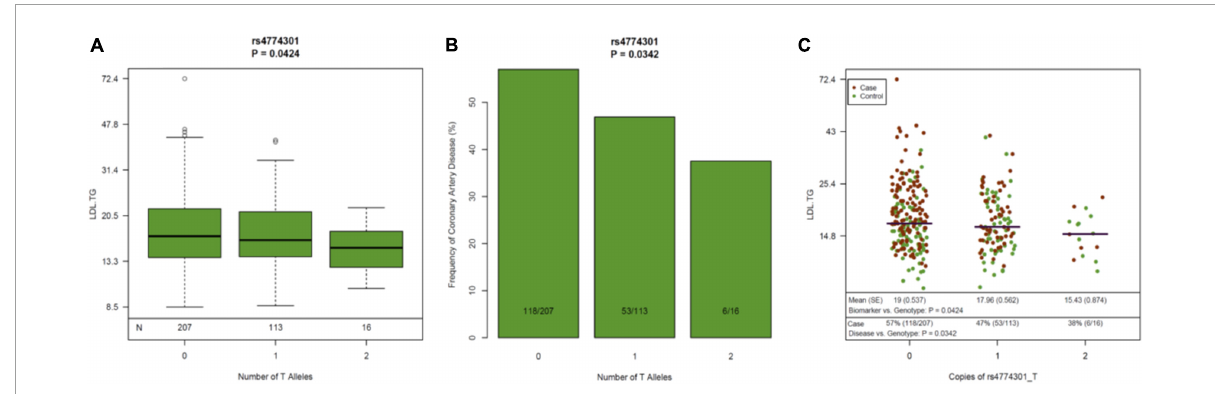
FIGURE4 Genetic variants in the LIPC Gene, Circulating Levels of LDL-TG and Atherosclerosis. The genetic variant rs4774301 in the LIPC genomic region is associated with significantly lower circulating levels of LDL-TG (A) and simultaneously, with significantly lower prevalence of atherosclerosis (B) . Jitter plot (C) demonstrates the same concept in a single graph, demonstrating that the number of the “T” alleles at rs4774301 is associated with lower circulating levels of LDL-TG and with lower prevalence of ASCAD. LIPC: hepatic lipase gene; LDL-TG: low density lipoprotein